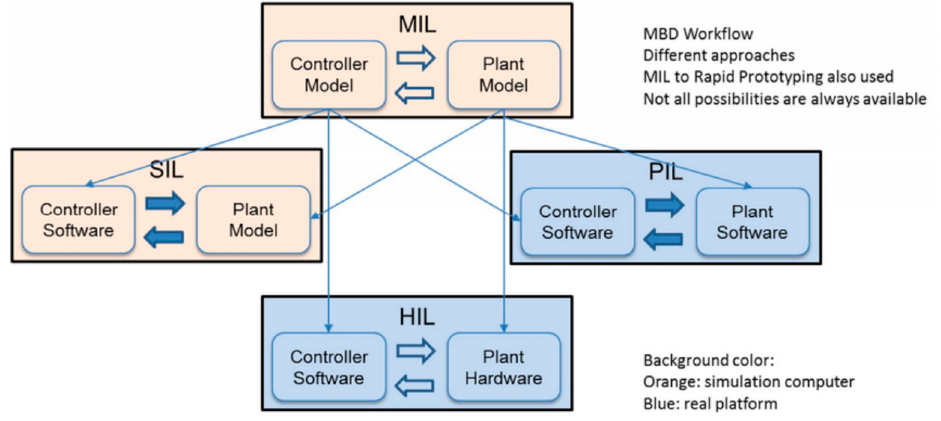
Figure 3. MBSE approach for rapid development and optimization of mechatronic systems.